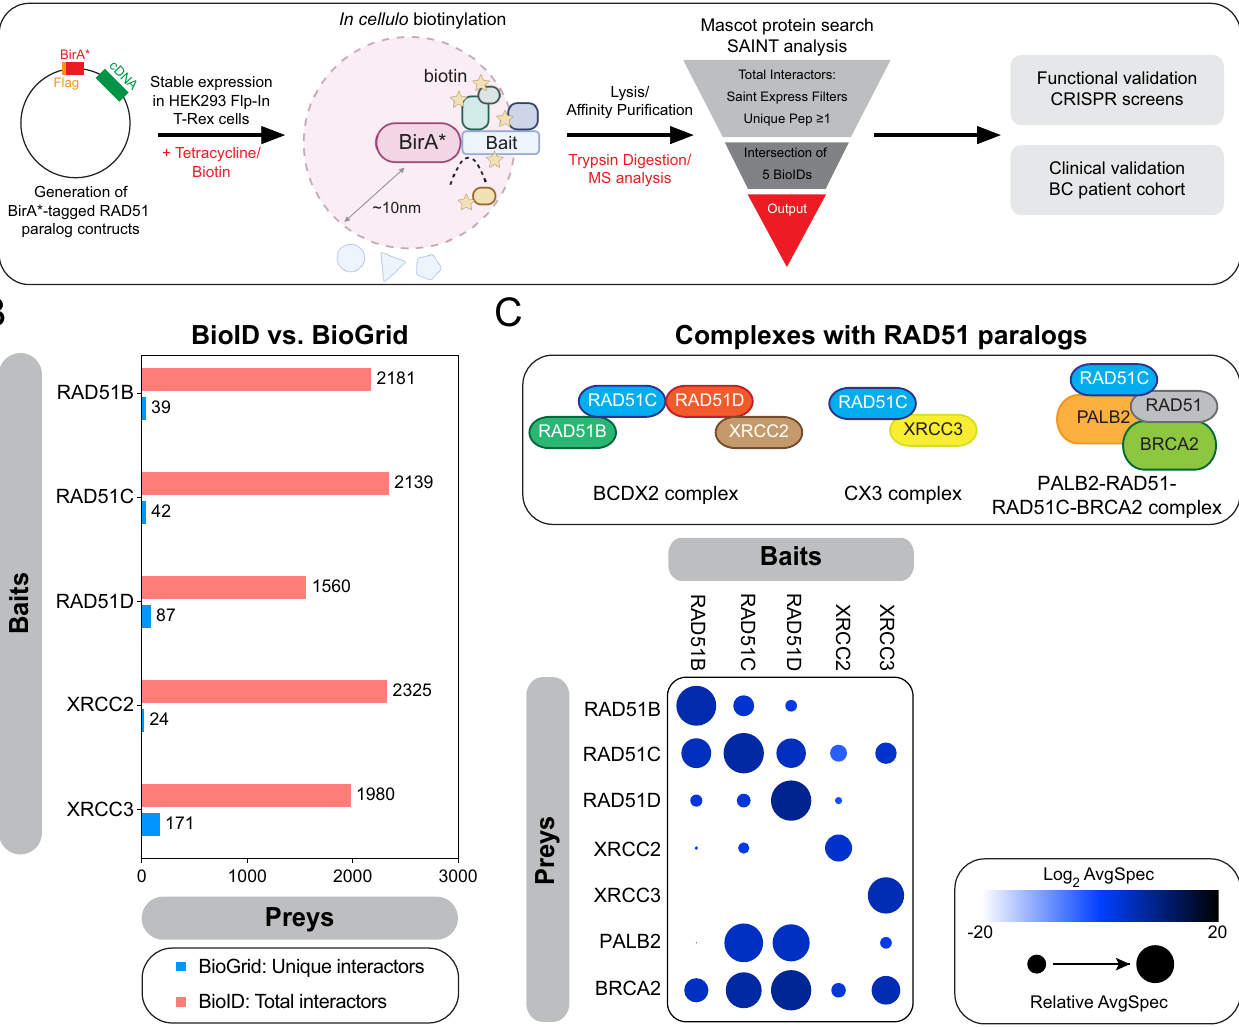
Fig 1. Proximal mapping of the RAD51 paralogs identifies known sub-complexes. (A) Schematic representing the experimental pipeline developed to map the proximal interactomes of the classical RAD51 paralogs and their subsequent functional and clinical validations. (B) Representation of the number of preys identified in each BioID in comparison to curated unique interactors annotated in the BioGRID database. (C) Top: schematic representing the well-established sub-complexes formed by the classical RAD51 paralogs. Bottom: selected BioID results, shown as dot plots. The spectral counts for each indicated prey protein are shown as AvgSpec. The circle size represents the relative abundance of preys over